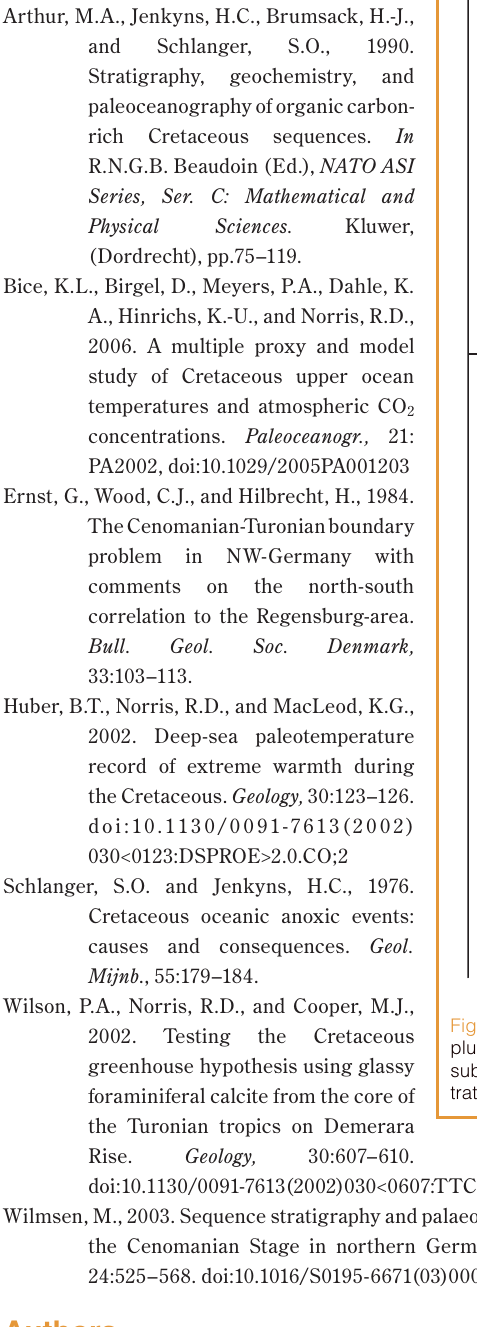
Fig. 1. Map from BGR Fig. 2. Photo by J. Erbacher Fig. 3. Photo by I. Jarvis